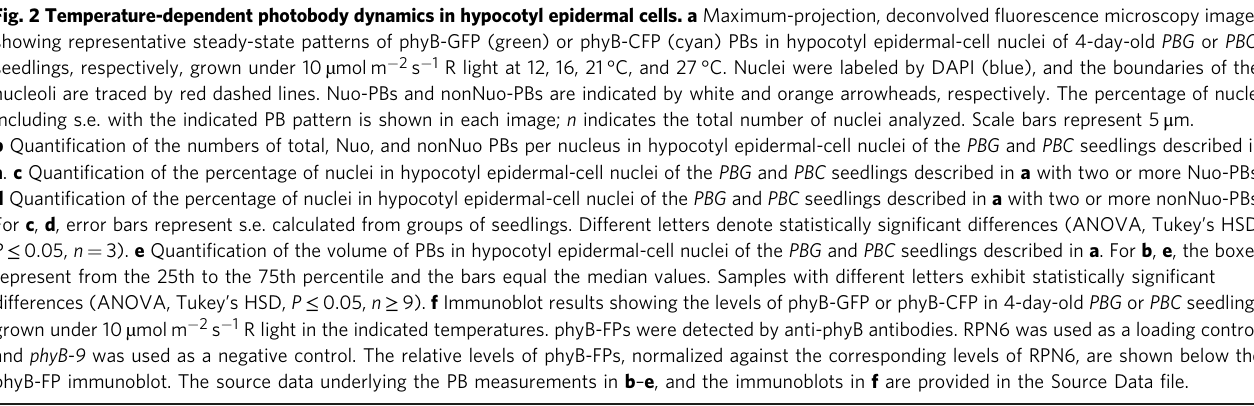
Fig. 2 Temperature-dependent photobody dynamics in hypocotyl epidermal cells. a Maximum-projection, deconvolved fl uorescence microscopy images showing representative steady-state patterns of phyB-GFP (green) or phyB-CFP (cyan) PBs in hypocotyl epidermal-cell nuclei of 4-day-old PBG or PBC seedlings, respectively, grown under 10 µ mol m − 2 s − 1 R light at 12, 16, 21 °C, and 27 °C. Nuclei were labeled by DAPI (blue), and the boundaries of the nucleoli are traced by red dashed lines. Nuo-PBs and nonNuo-PBs are indicated by white and orange arrowheads, respectively. The percentage of nuclei including s.e. with the indicated PB pattern is shown in each image; n indicates the total number of nuclei analyzed. Scale bars represent 5 μ m. b Quanti fi cation of the numbers of total, Nuo, and nonNuo PBs per nucleus in hypocotyl epidermal-cell nuclei of the PBG and PBC seedlings described in a . c Quanti fi cation of the percentage of nuclei in hypocotyl epidermal-cell nuclei of the PBG and PBC seedlings described in a with two or more Nuo-PBs. d Quanti fi cation of the percentage of nuclei in hypocotyl epidermal-cell nuclei of the PBG and PBC seedlings described in a with two or more nonNuo-PBs. For c , d , error bars represent s.e. calculated from groups of seedlings. Different letters denote statistically signi fi cant differences (ANOVA, Tukey ’ s HSD, P ≤ 0.05, n = 3). e Quanti fi cation of the volume of PBs in hypocotyl epidermal-cell nuclei of the PBG and PBC seedlings described in a . For b , e , the boxes represent from the 25th to the 75th percentile and the bars equal the median values. Samples with different letters exhibit statistically signi fi cant differences (ANOVA, Tukey ’ s HSD, P ≤ 0.05, n ≥ 9). f Immunoblot results showing the levels of phyB-GFP or phyB-CFP in 4-day-old PBG or PBC seedlings grown under 10 µ mol m − 2 s − 1 R light in the indicated temperatures. phyB-FPs were detected by anti-phyB antibodies. RPN6 was used as a loading control, and phyB-9 was used as a negative control. The relative levels of phyB-FPs, normalized against the corresponding levels of RPN6, are shown below the phyB-FP immunoblot. The source data underlying the PB measurements in b – e , and the immunoblots in f are provided in the Source Data fi